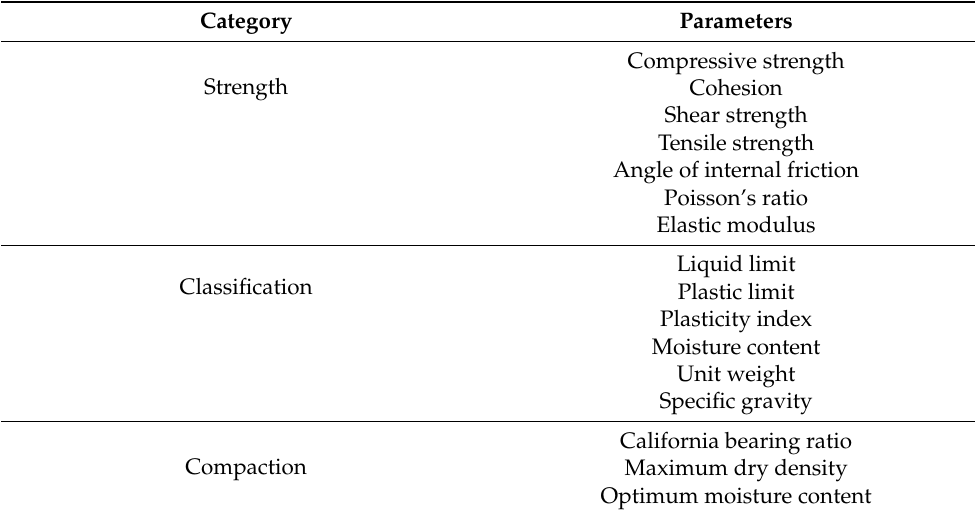
Table 1. List of laboratory test parameters considered in this